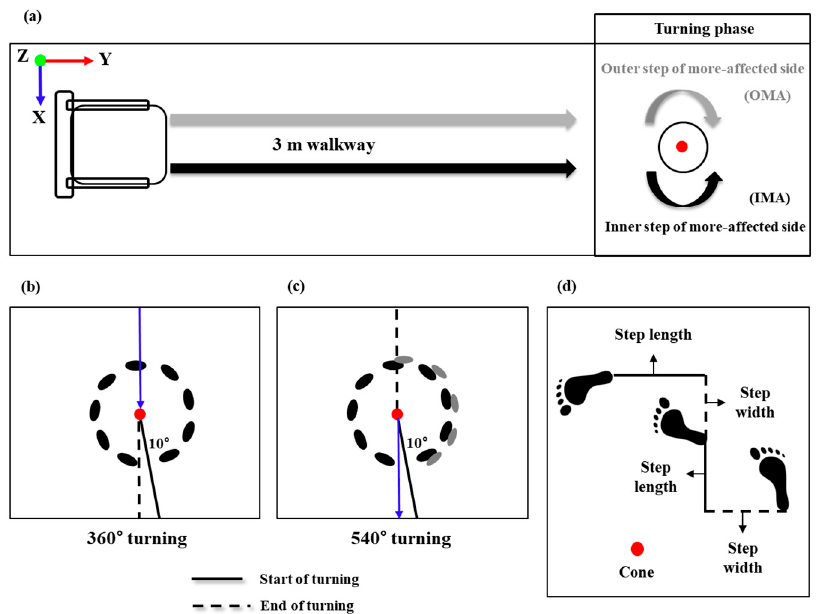
Figure 2. Schematic of the data collection and analysis phase. ( a ) The 360° turning task involved